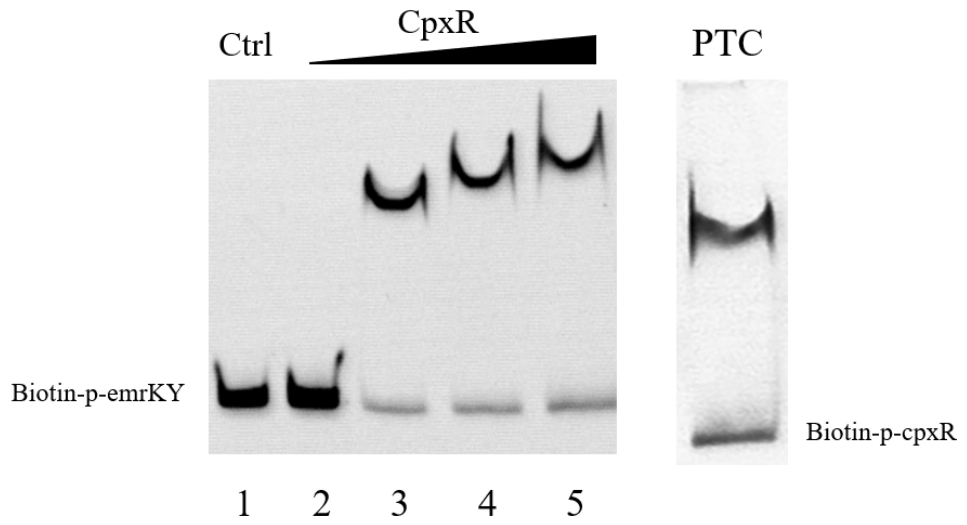
Figure 5. The binding ability of CpxR to the emrKY promoter was determined by EMSA. Lanes 1–5: the CpxR concentrations in order of 4, 0, 1, 2, and 4 µ M, the amounts of biotin-labeled probes in all lanes were 200 fM, with an additional 2 pM of unlabeled probe added to lane 1 as a competition control (Ctrl). The positive control (PTC) indicated that CpxR was able to bind to its own promoter.